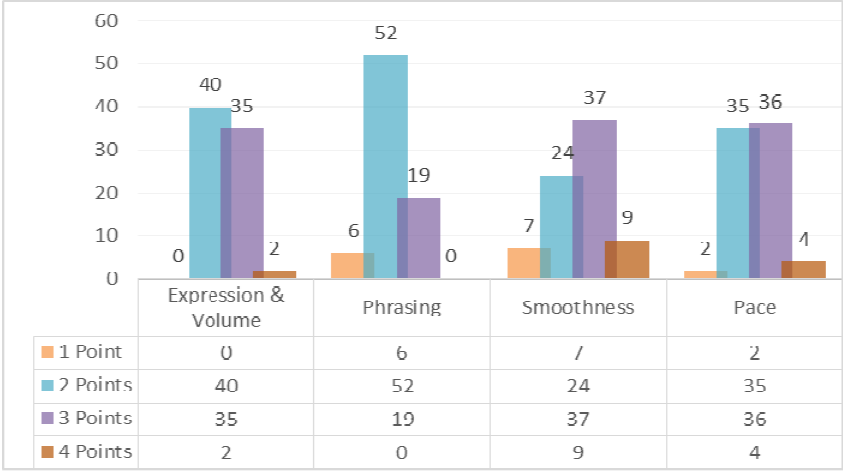
Figure 1. Frequency of prosodic